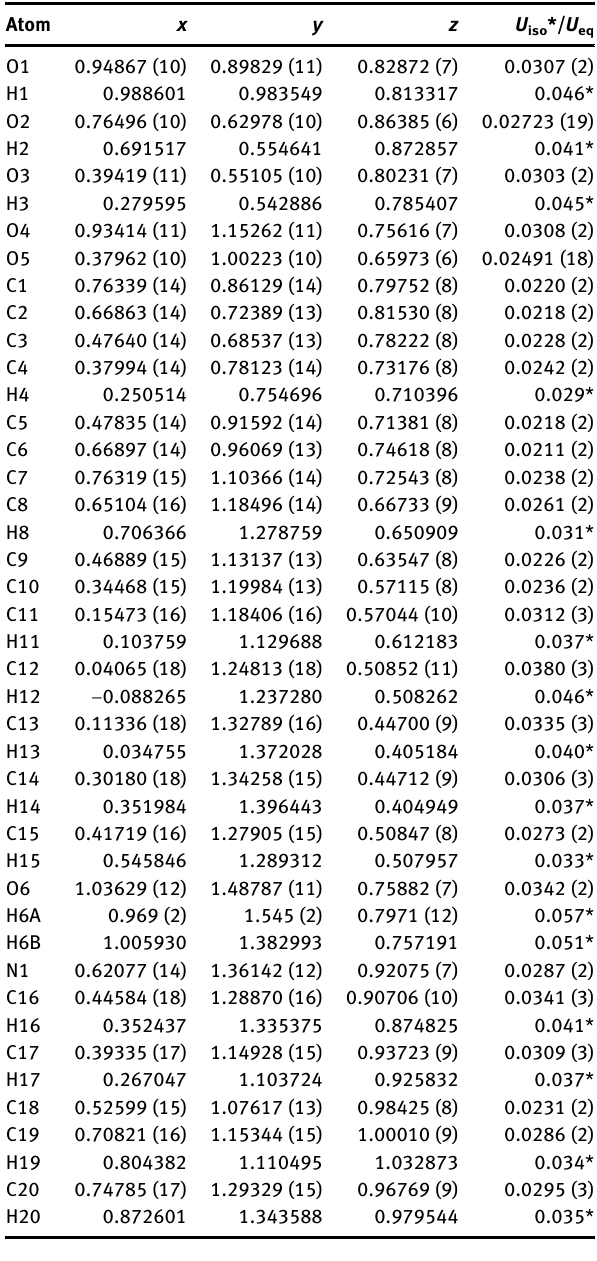
Table  : Fractional atomic coordinates and isotropic or equivalent isotropic displacement parameters (Å 